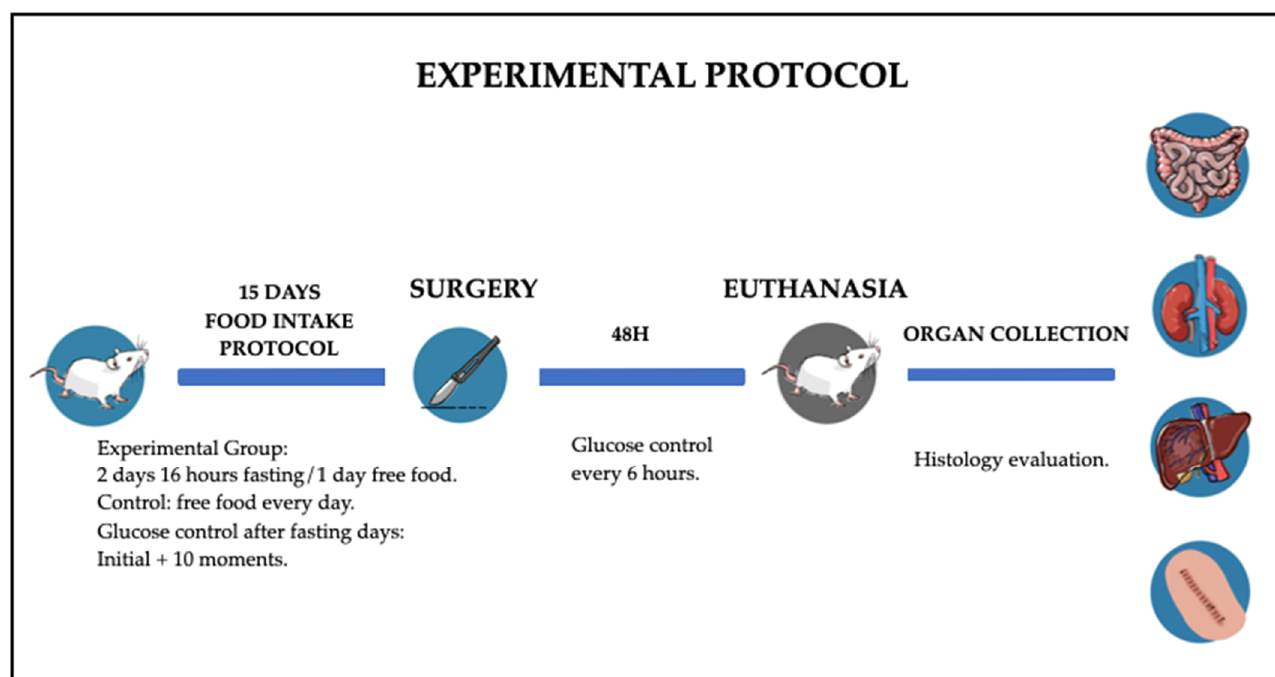
Figure 1. Schematic image of experimental protocol in diabetic rats of our study.